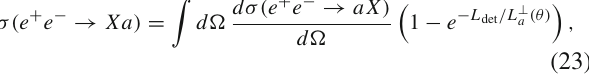
, m 2 (cid:11) s < (cid:2) , a Z